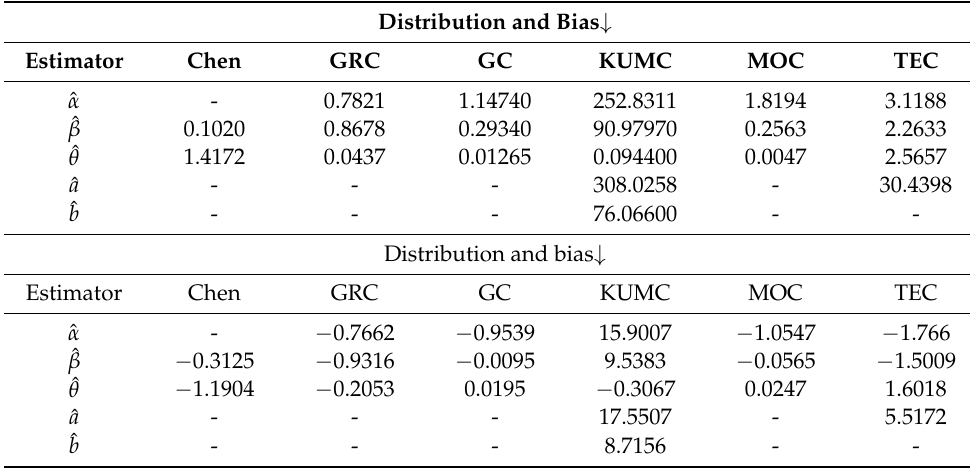
Table 9. Results for samples generated from the Chen distribution with n = 50.